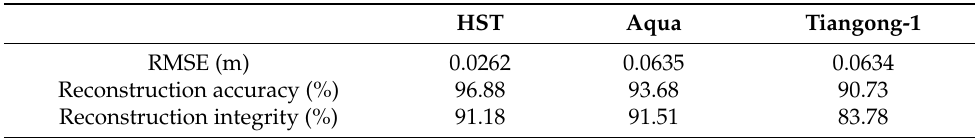
Table 2. The evaluation values of the reconstructed